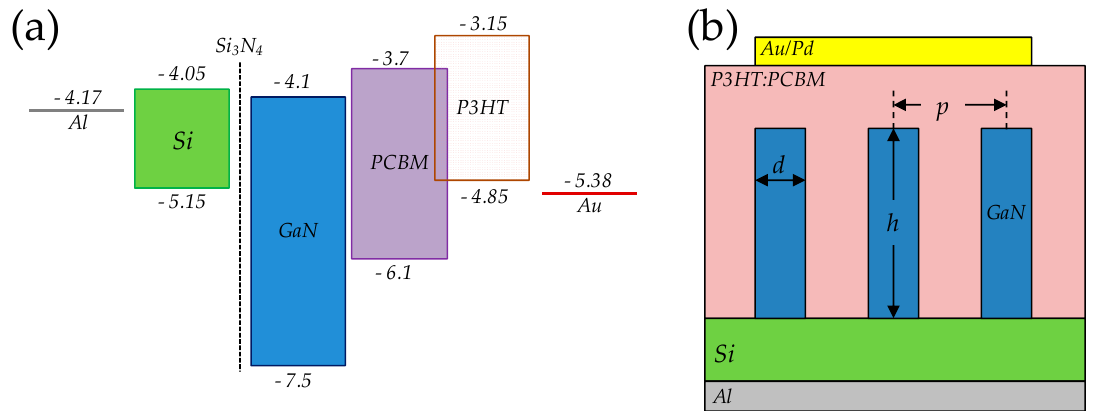
Figure 1. ( a ) Theoretical energy band alignment of Si / GaN NW / P3HT:PC 71 BM hybrid heterostructure. Energy levels are in eV. ( b ) Structure schematic with designated nanostructure diameter d , height h and pitch p . Relative distances not to scale.